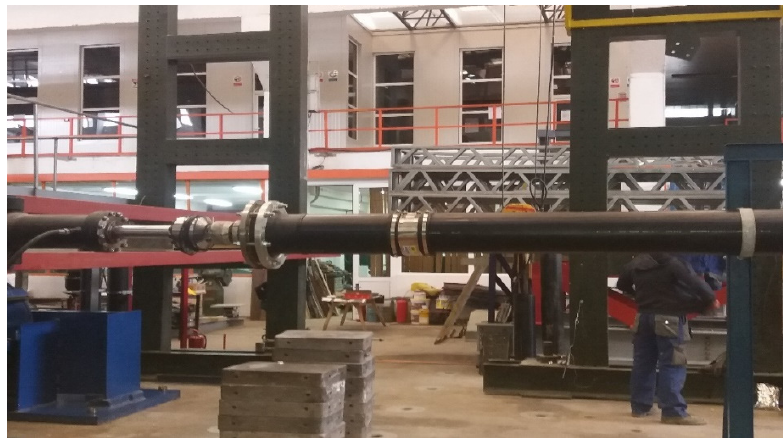
Figure 2. System Consisting of Two Pipeline Sections Joined by Flexseal SC250.